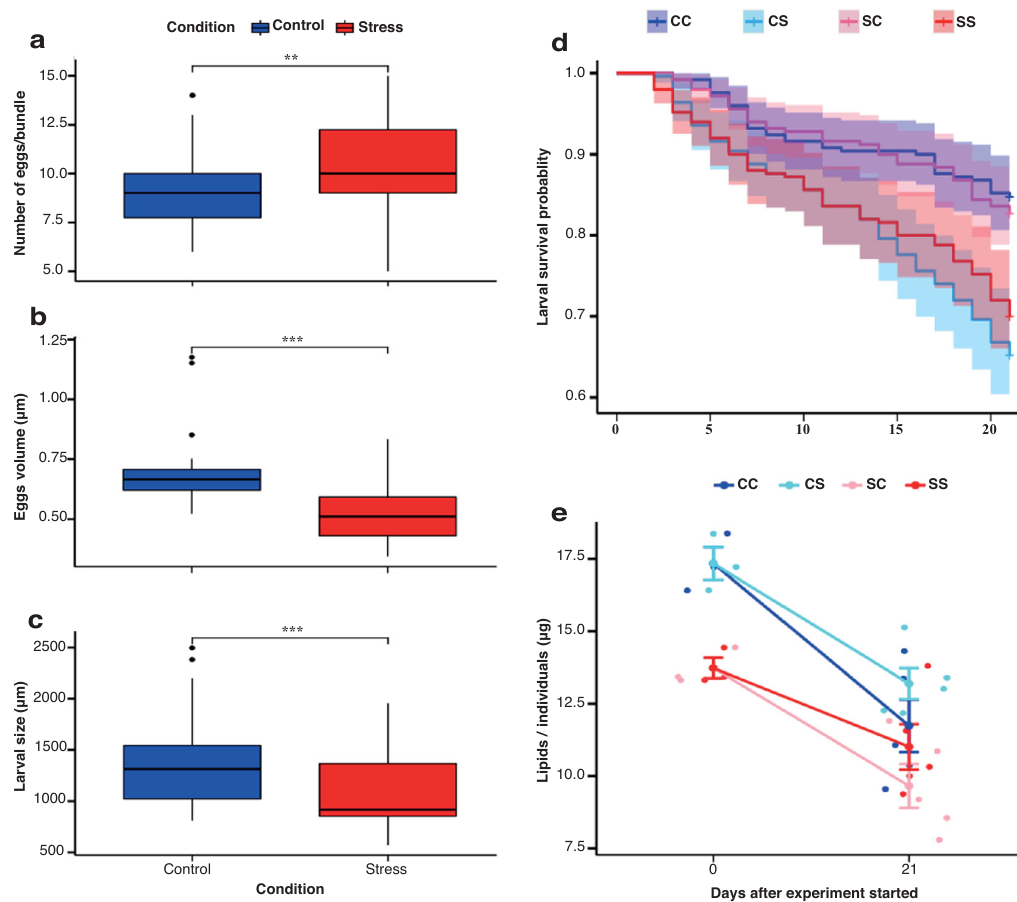
Fig. 3 Carryover effects of thermal stress on fecundity of Acropora tenuis (Experiment 2). a Number of eggs in the bundles of control (blue) and stressed (red) fragments . The average number of eggs for 6 bundles in each treatment group is shown (stress; n = 24 bundles from 4 colonies, control; n = 30 bundles from 5 colonies). The values differ signi fi cantly between treatments (unpaired two-sampled Wilcoxon test, p = 0.003). b Egg volume from control (blue) and stressed (red) fragments . The egg volume in bundles is signi fi cantly different between the stressed (red, n = 20) and control (blue, n = 20) fragments (unpaired two-sampled Wilcoxon test, p = 0.0002). c Mean larvae sizes (5 days post-fertilization) from gametes in the control (blue) and stressed (red) treatment groups . Larval sizes differ signi fi cantly between stressed fragments (SF, red; n = 45) and control fragments (CF, blue; n = 69) (unpaired two-sample Wilcoxon test, p = 0.00003). d Larval survival (%) in the two treatment groups ( n = 100 per treatment) exposed to control conditions (SC, pink line; CC, dark blue line) and thermal stress (SS, red line; CS: cyan line). The survival curves show the effect of thermal stress on larval survival in the control and thermal stress conditions over 21 days (Kaplan – Meier log-rank test, Supplementary Table 1). The survival curves of larvae under thermal stress (CS and SS) are not different between treatments (Kaplan – Meier log-rank test, p = 0.37). Shading indicates 95% CI. e Lipid consumption rates in larvae obtained from the gametes of control fragments (CC: dark blue, CS: cyan) and stressed fragments (SS: red, SC: pink) at different temperatures. In the all larval experiments, the control conditions were ambient temperature in early summer. The water temperatures changed within a day and during experimental days. Error bars indicate standard errors (S.E.). CC indicates larvae or recruits from the control fragments (CF) in the control condition, CS is larvae or recruits from CF in the stressed condition, SC is larvae or recruits from the stressed fragments (SF) in the control condition, and SS is larvae or recruits from SF in the stressed